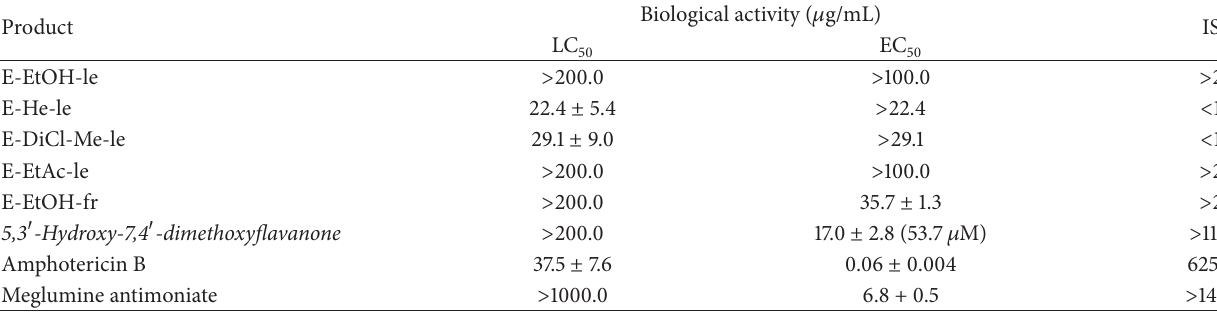
Table 1: In vitro cytotoxicity and antileishmanial activity of Picramnia gracilis Tul.